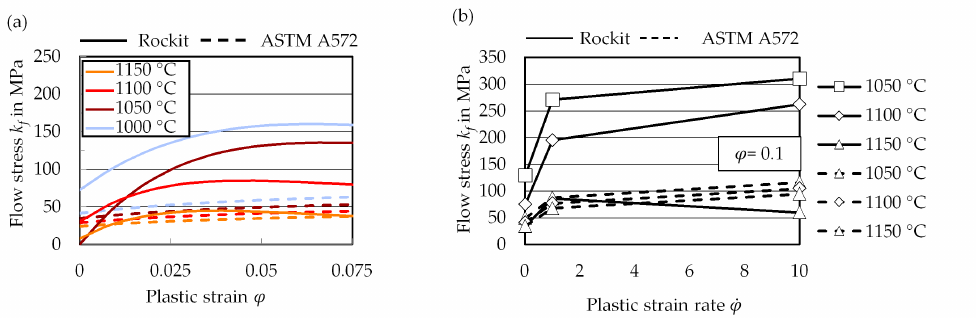
Figure 11. Flow curves of the coating material (Rockit ® ) and the substrate material (ASTM A572) ( a ), influence of the strain rate at ϕ = 0.075 on the flow stress at different test temperatures ( b